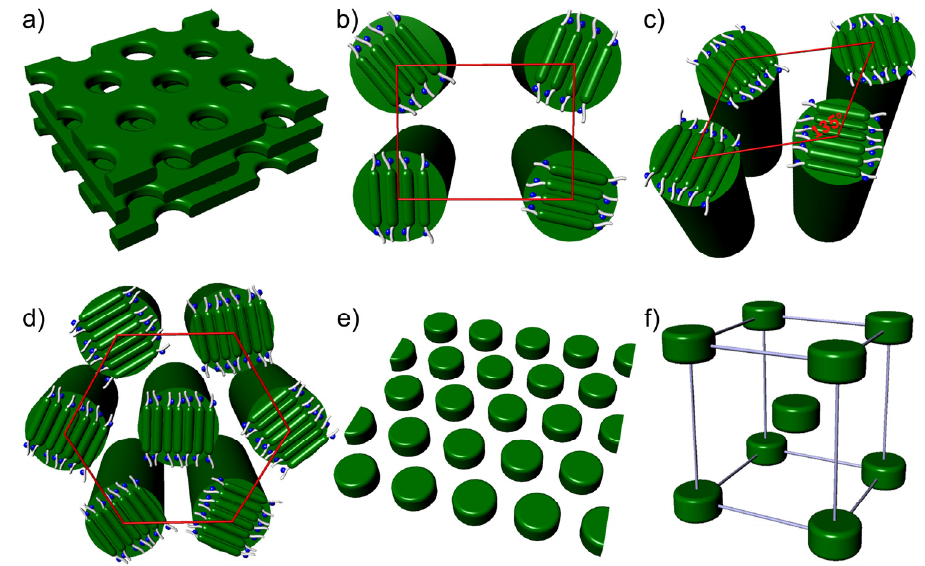
Figure 5. Schematic representation of self-assembly of ( a ) hexagonal perforated layer structure for 1a ; ( b ) Rectangular columnar structure for 1a ; ( c ) Oblique columnar structure for 1a ; ( d ) Hexagonal column for 1c ; ( e ) Hexagonal close-packed structure for 1b ; ( f ) Body-centered tetragonal structure for 1c